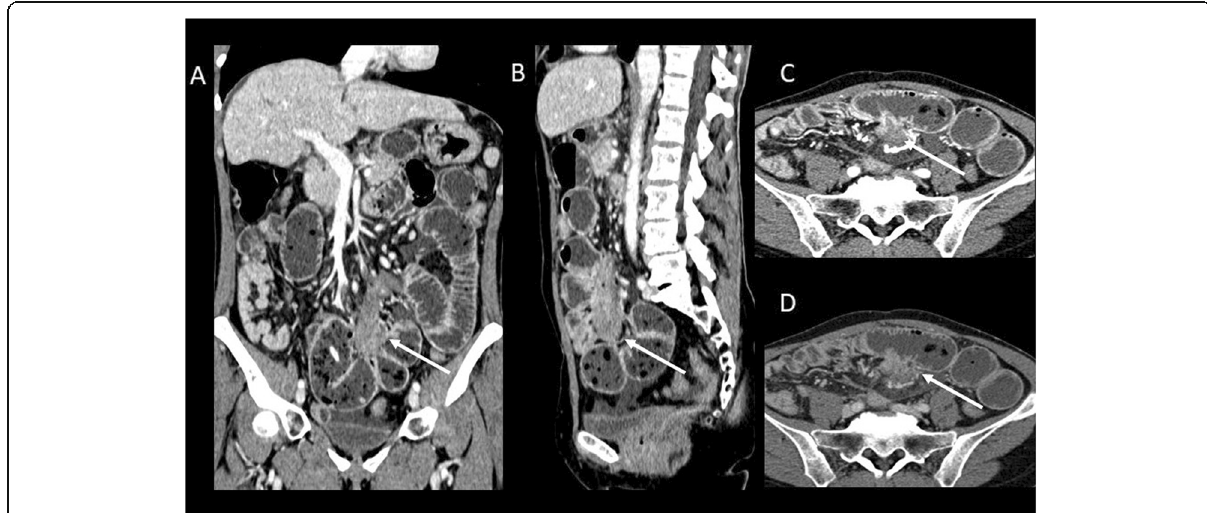
Fig. 7 Mesenteric DT. A 54-year-old female patient with a positive history for previous surgery (hystero-annessiectomy) and chronic liver disease. CT images (( a ) coronal, ( b ) sagittal, and ( c , d ) axial plane) show a poorly defined border lesion (arrow) with radiating spicules extending into the adjacent mesenteric fat and infiltrating the small bowel causing small bowel obstruction. Axial arterial phase ( c ) and portal phase ( d ) show progressive contrast enhancement of the lesion